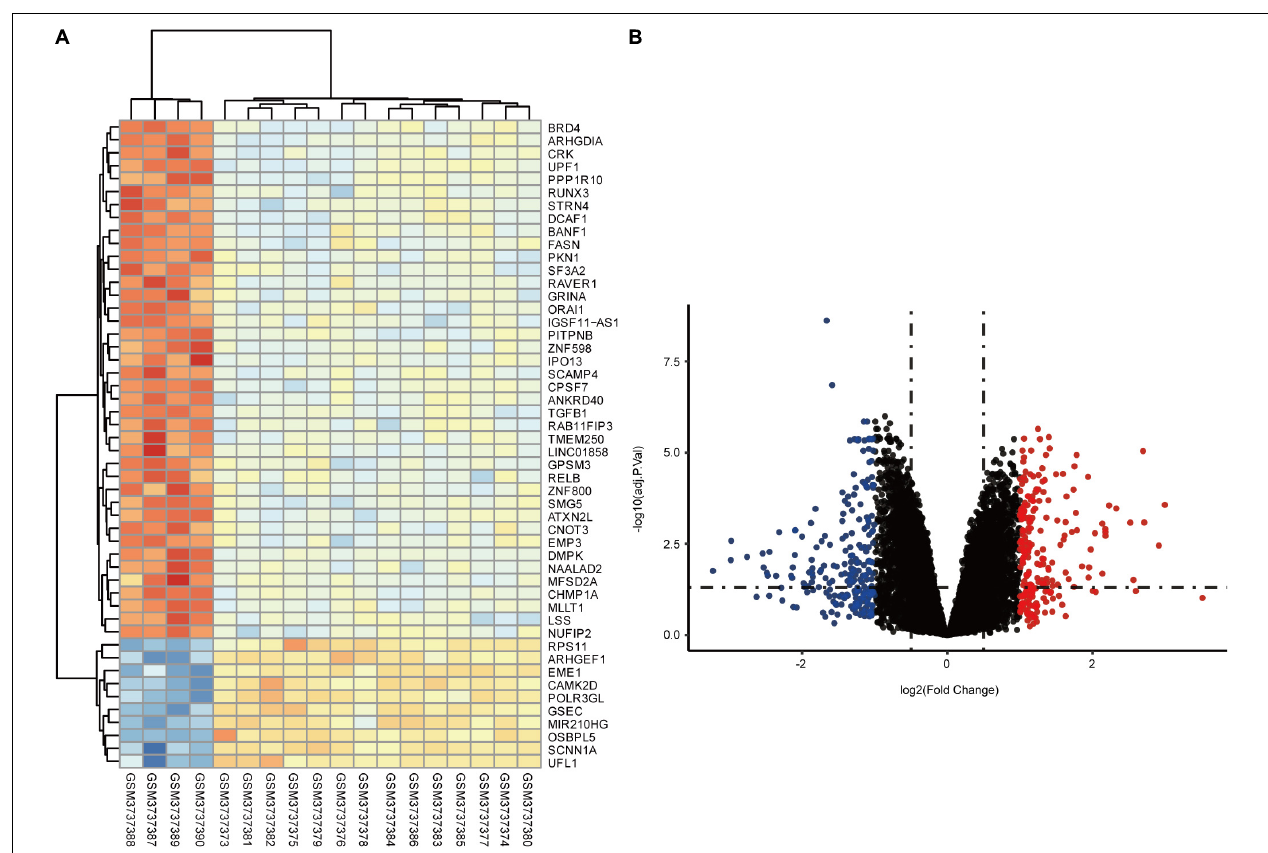
FIGURE 2 | Identification of DEGs between control and CTEPH samples. (A) Heatmap showing the DEGs between two groups. (B) Volcano plot showing the DEGs between two groups. The X -axis represents the | logFC| and the Y -axis represents the p -value (log-scaled). FC, fold